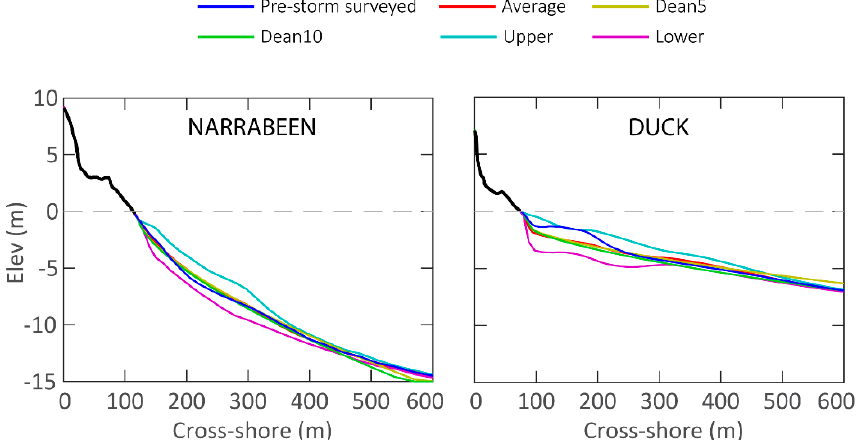
Figure 2. Examples of the six alternative nearshore and surf zone bathymetries used to explore the sensitivity of XBeach sub-aerial erosion predictions to pre-storm bottom boundary conditions. The pre-storm surveyed sub-aerial beach (black) and Pre-Storm Surveyed bathymetry (blue) are shown for the June 2016 storm event at Narrabeen ( left ) and September 2017 storm event at Duck ( right ).